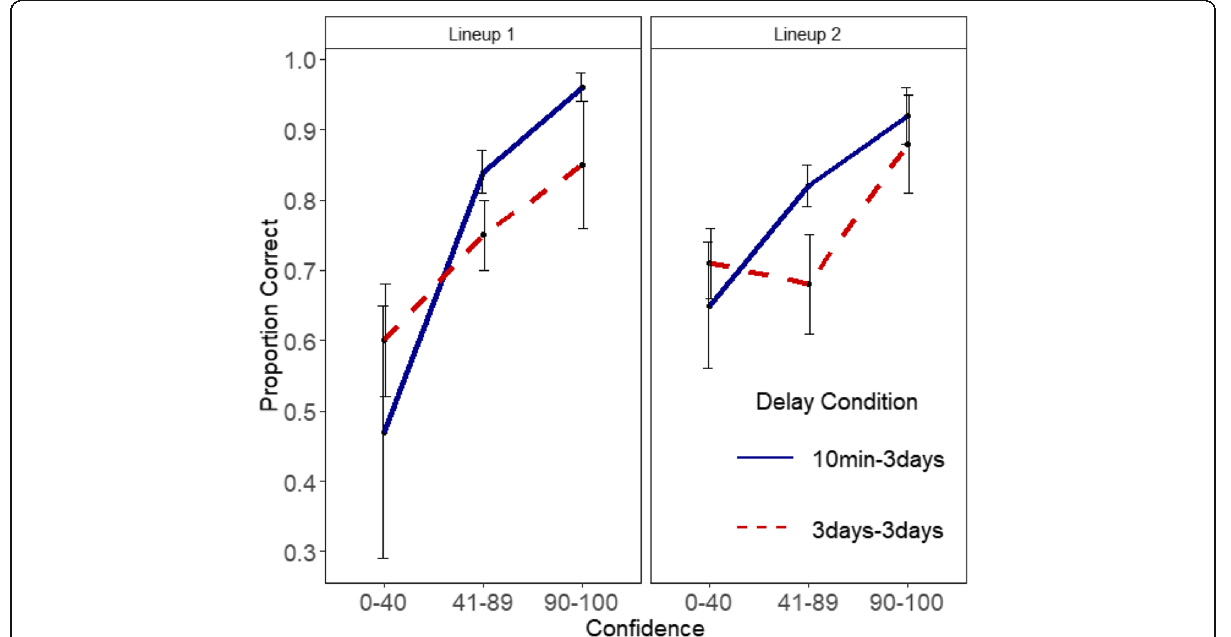
Fig. 6 Experiment 1 CAC plots for Lineups 1 and 2. Error bars are standard